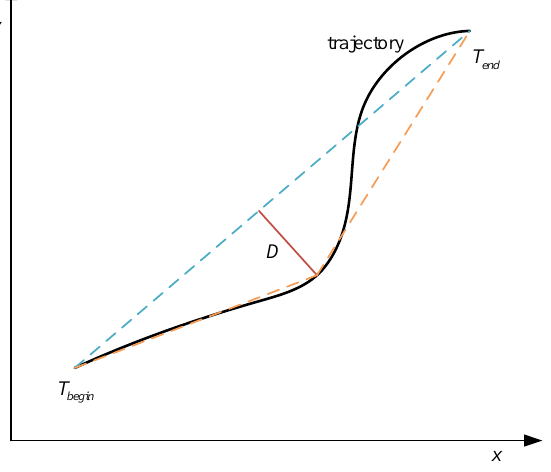
Figure 10. Schematic of PLS. Algorithm 3. Algorithm for filter segments.